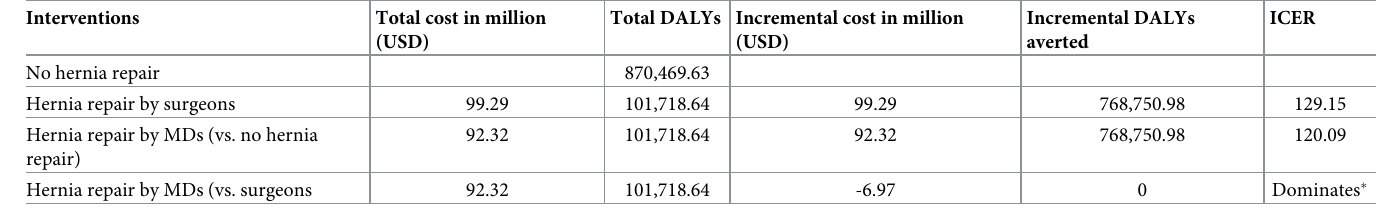
Table 6. Cost-effectiveness analysis of mesh repair by different providers in Ghana (n =